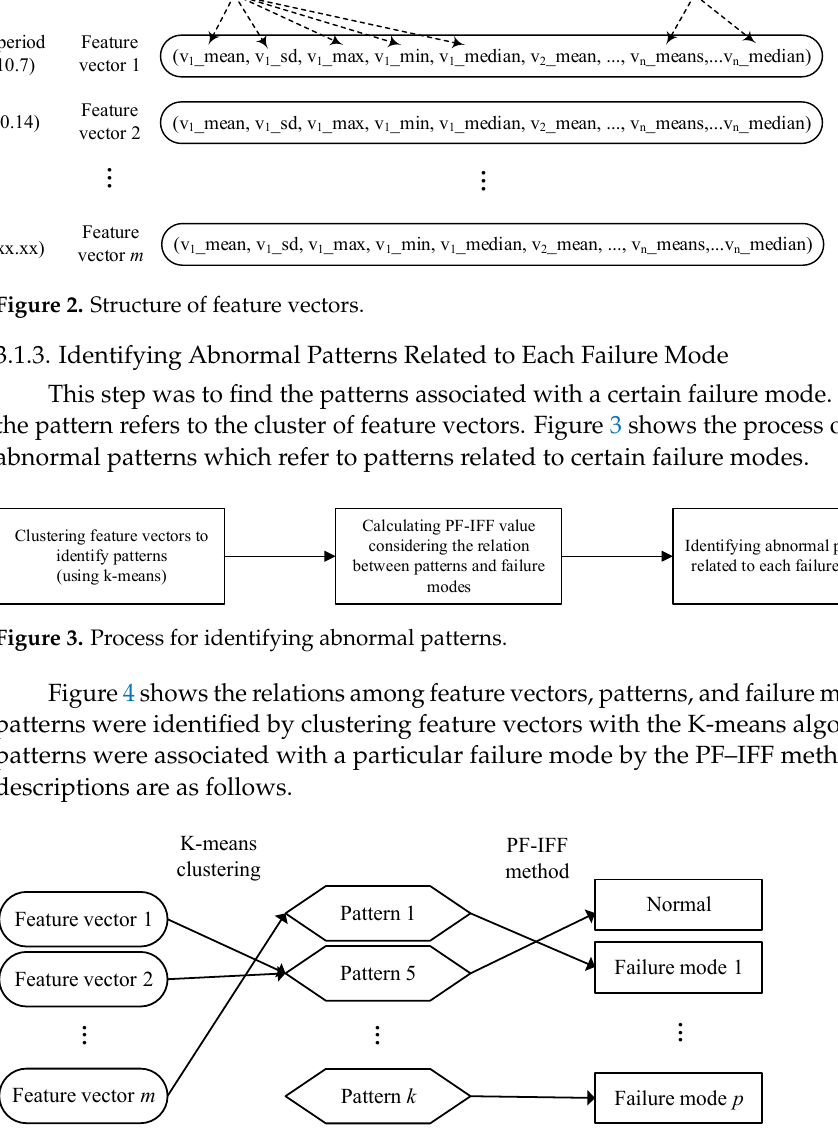
Figure 4. Relations among feature vectors, patterns, and failure modes.